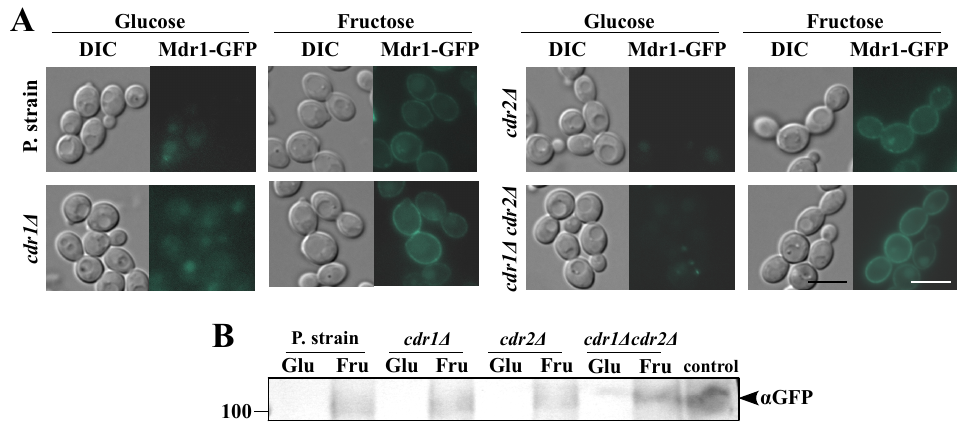
Figure 4. ( A ) Fluorescence micrographs of the subcellular localization of Mdr1p-GFP in the C. albicans strains KS070 (CAF2-1 MDR1-GFP ), KS075 (DSY448 MDR1-GFP ), KS074 (DSY653 MDR1-GFP ), and KS073 (DSY654 MDR1-GFP ). Scale bar = 5 µm. ( B ) Immunoblot analysis of Mdr1p-GFP in C. albicans KS070, KS075, KS074, and KS073. A positive control was obtained by treating the KS070 strain with 3% H 2 O 2 for 4 h. In both presented experiments, the C. albicans strains were grown in yeast nitrogen base glucose (YNBG) or yeast nitrogen base fructose (YNBF) media for 8 h at 28 °C.